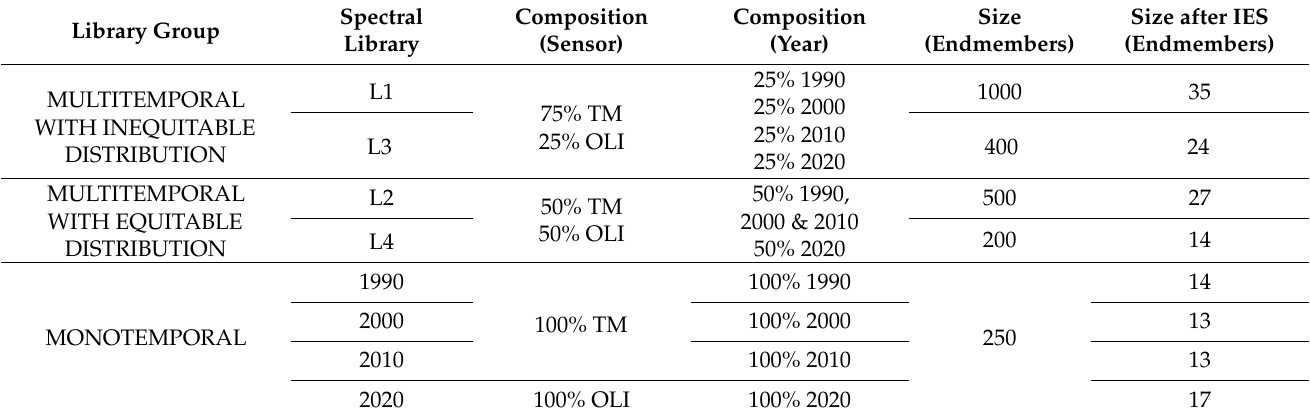
Table 1. Characteristics and composition of the developed spectral